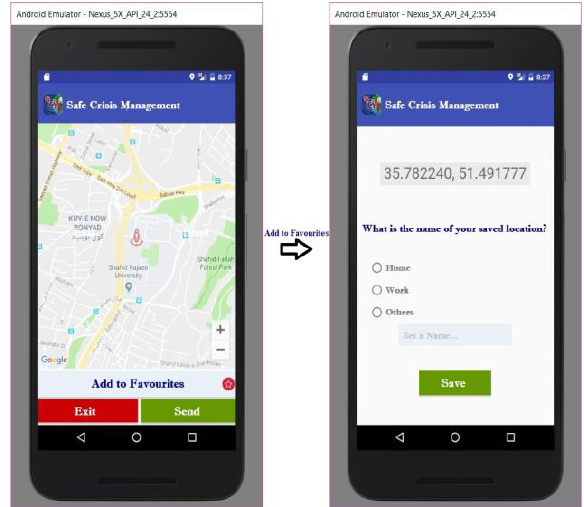
Figure 16. Save location